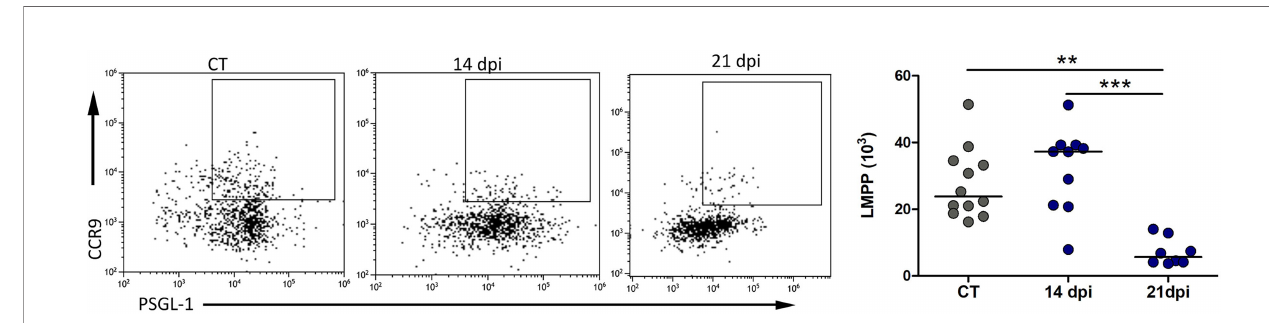
FIGURE 4 | Reduced numbers of downstream LMPPs in the bone marrow of Trypanosoma cruzi orally infected mice. Representative dot plots of LMPP (Lin − Sca- 1 + c-kit + FLT3 + PSGL-1 + CCR9 + ) and absolute cell number along with days post-infection. Bars indicate the medians in each group; circles depict individual animals.